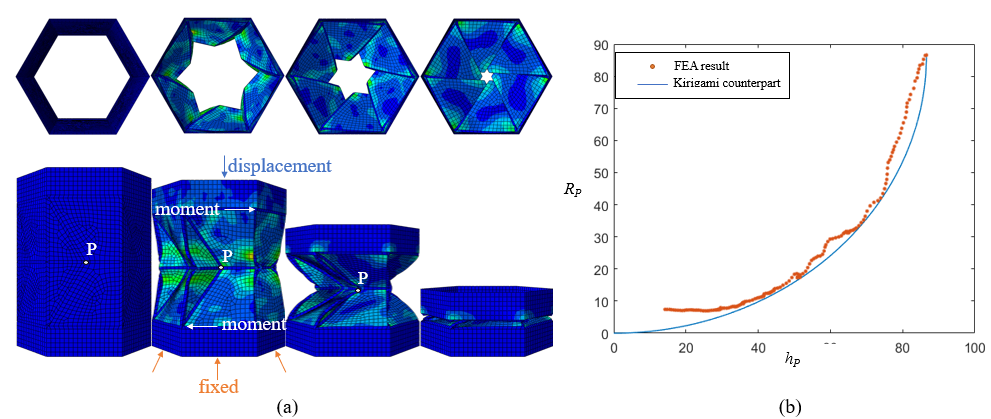
Figure 11. ( a ) FEA simulation folding process. ( b ) The trajectories of point P i under the FEA results and the rigidly foldable kirigami counterpart result. ( n = 6).